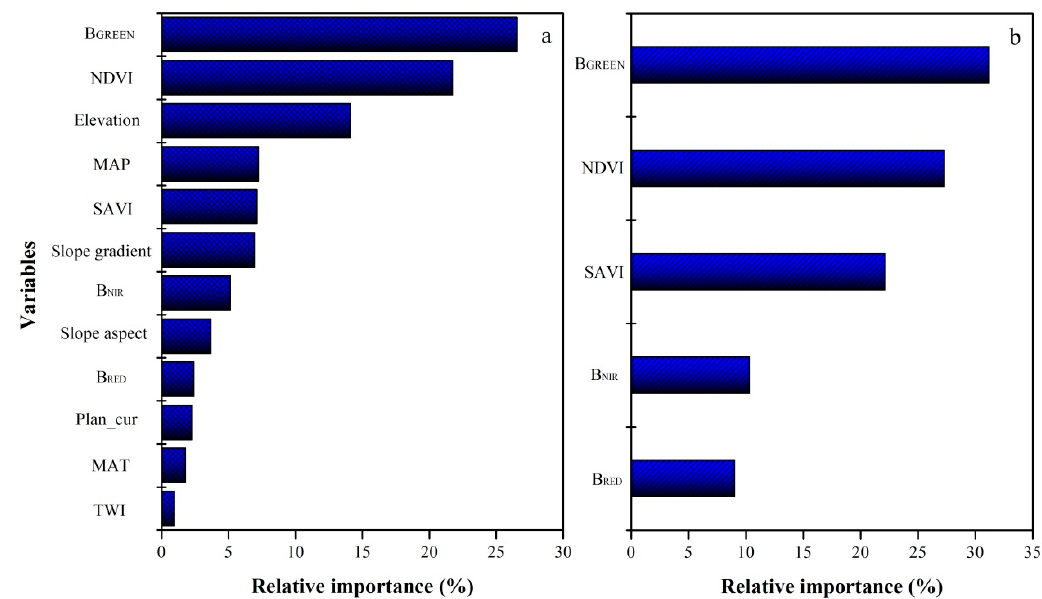
Figure 6. Relative importance of each prediction variable in full variable model (Model A) ( a ) and only multispectral remote sensing variables (Model C) ( b ). B GREEN , green band; B RED , red band 4; B NIR , near-infrared band; NDVI , normalized difference vegetation index; SAVI , soil adjusted vegetation index; Plan_cur, plan curvature; TWI, topographic wetness index; MAP, mean annual precipitation; MAT, mean annual temperature. Remote Sens. 2020 , 12 , 393